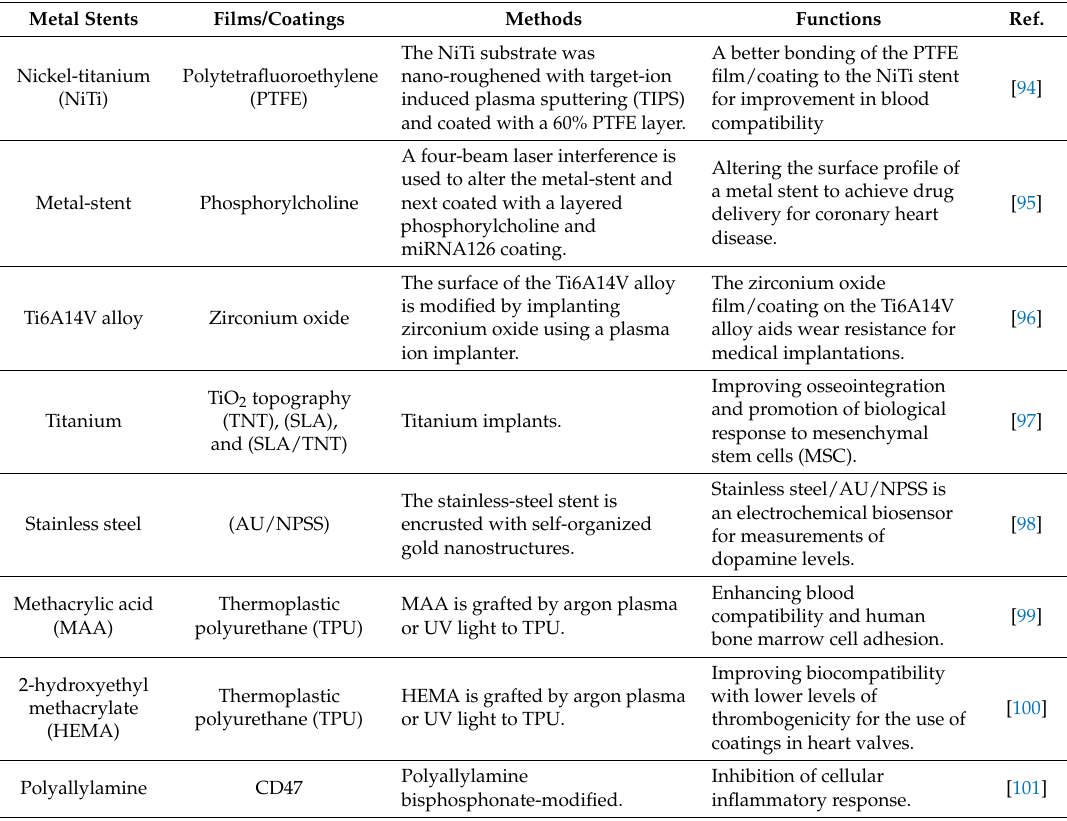
Table 1. Metal-based stents and anti-coagulation films/coatings for thrombosis applications. Metal Stents